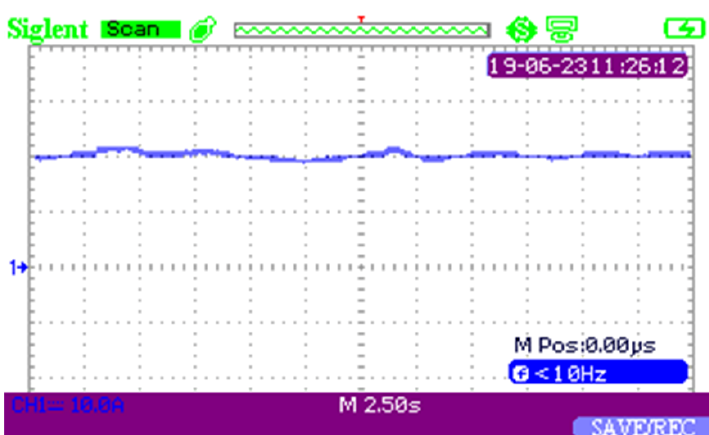
Figure 10. Oscillogram of the measured DC current of protection and control system’s DC auxiliary system in a large substation.